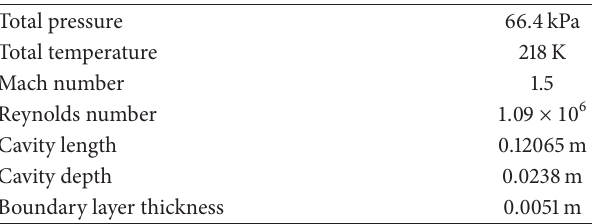
Figure 2: Schematic view of the cavity configuration. Table 1: Numerical and experimental parameters for the prelimi- nary CFD study.